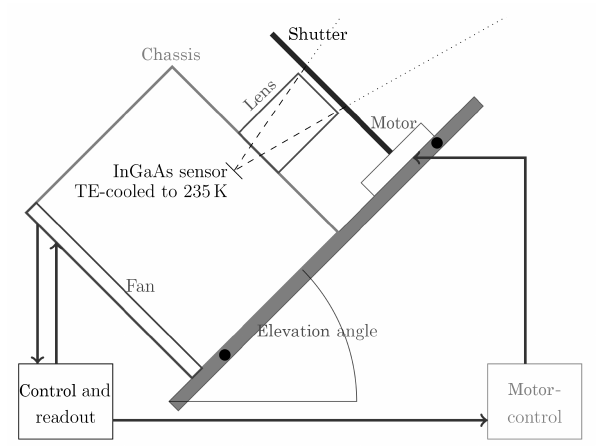
Figure 1. Sketch of the instrument and measurement set-up. See text for further